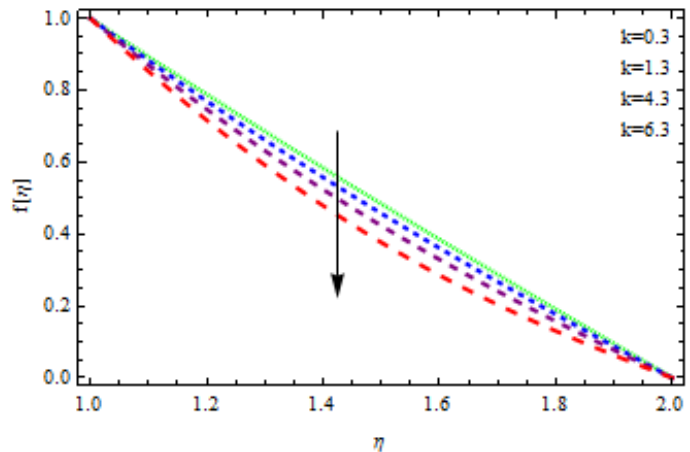
Figure 3. Influence of k on the velocity curve.